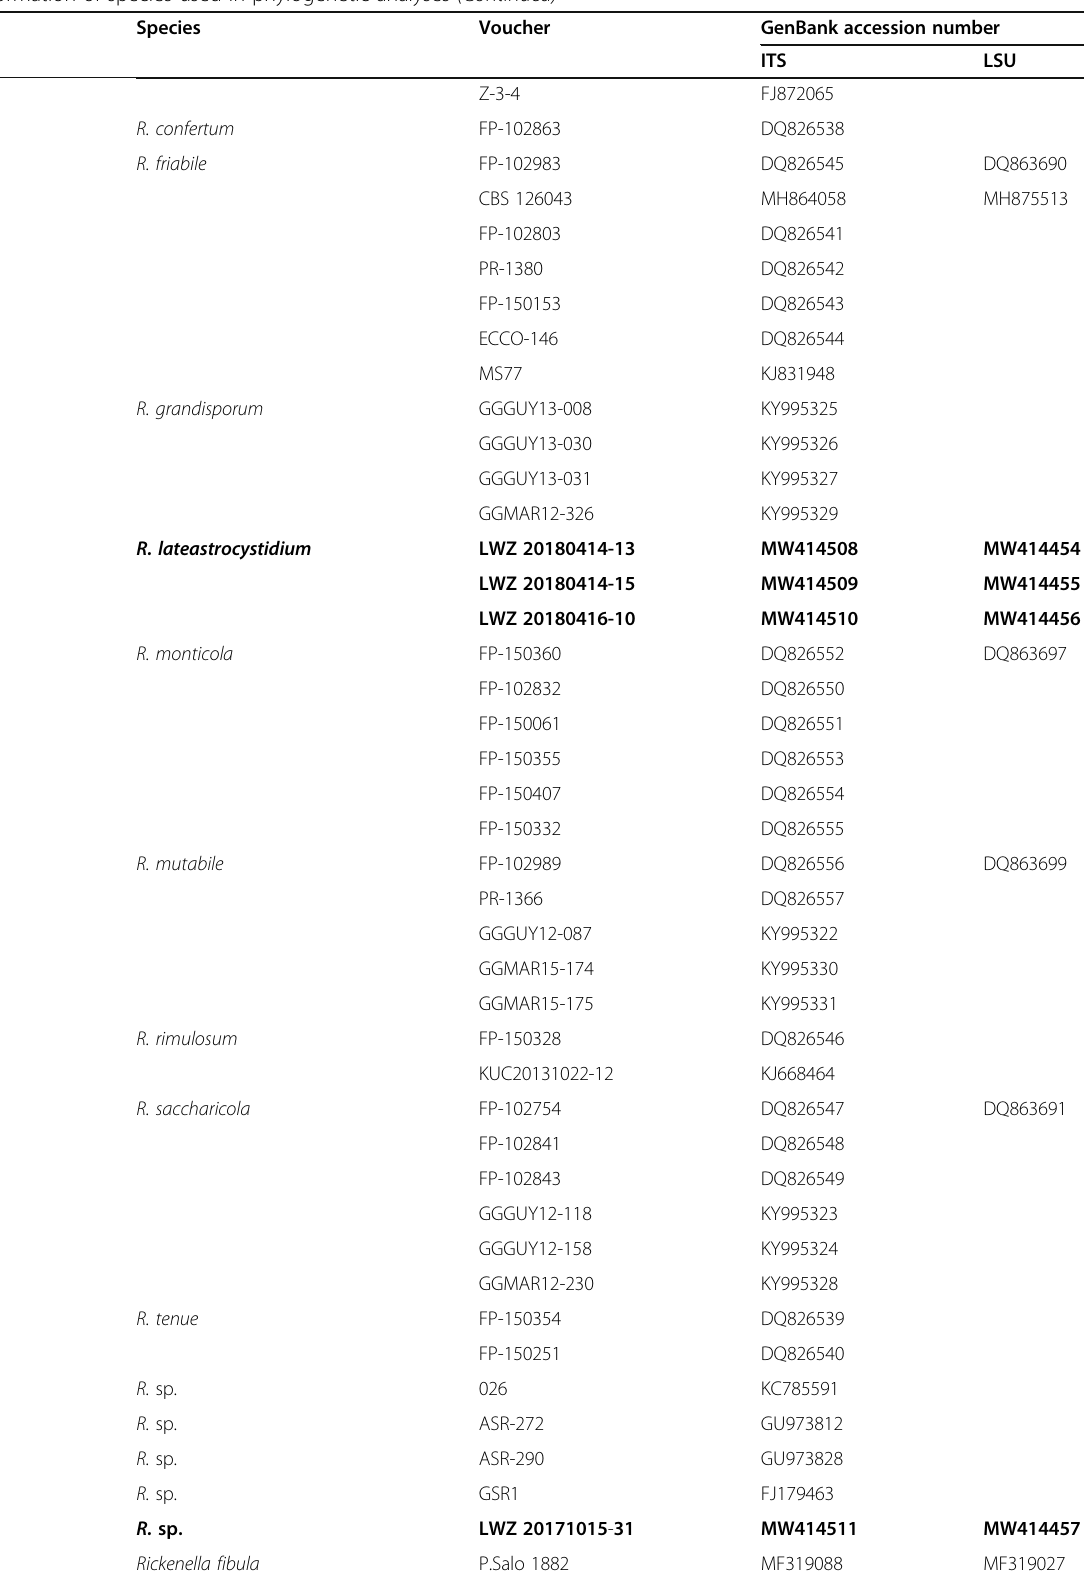
Table 1 Information of species used in phylogenetic analyses (Continued)